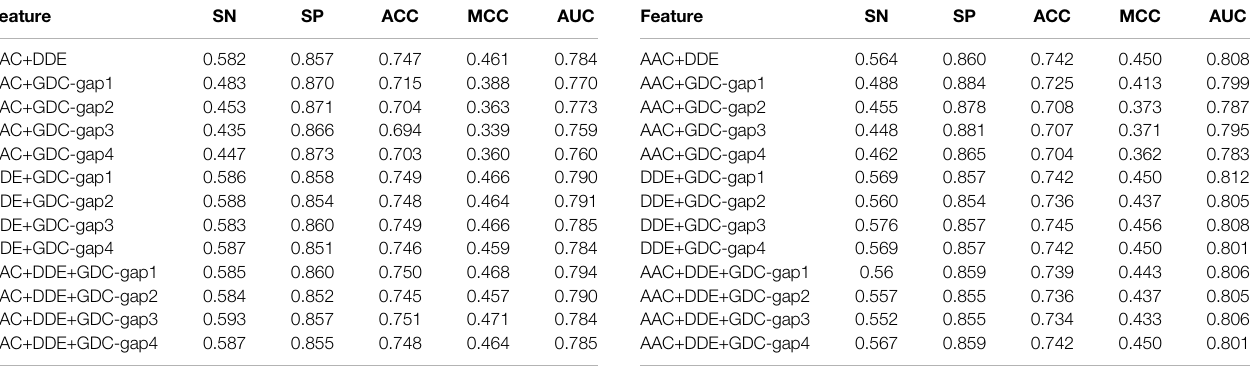
TABLE 2 | Performance comparison of various combined features of fi vefold cross-validation on the training dataset. Feature SN